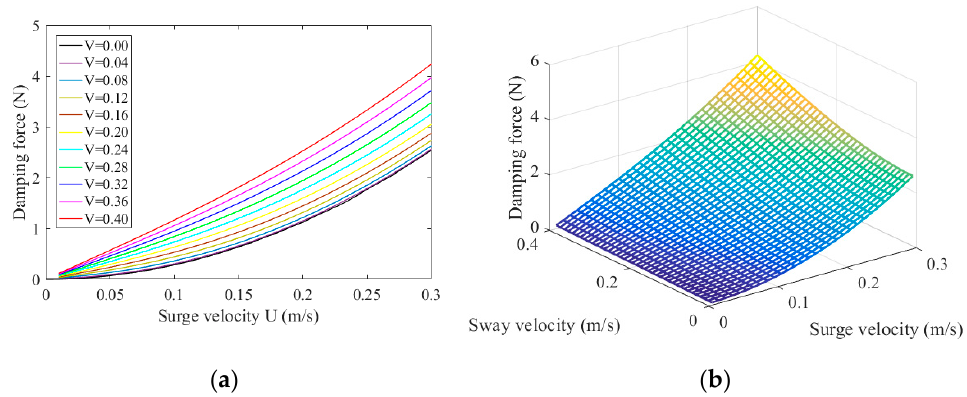
Figure 6. The damping force characteristics under disturbance. ( a ) The damping force changing with surge velocity under different disturbance velocities; ( b ) The three-dimensional curve relating the damping force, surge velocity and the disturbance velocity (sway velocity).